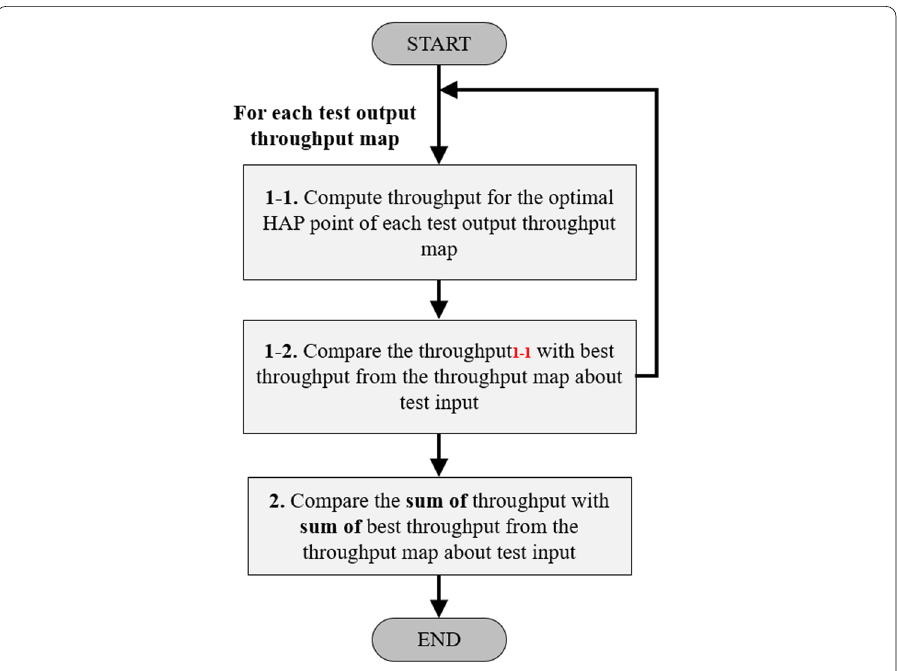
Fig. 5 Flow chart of design of testing. Note that 1‑1 after the description of stage 1‑2 means the data of stage 1‑1 is used in stage